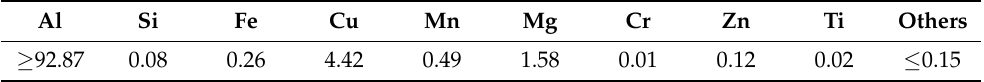
Table 1. Chemical composition of the 2A12 aluminum alloy